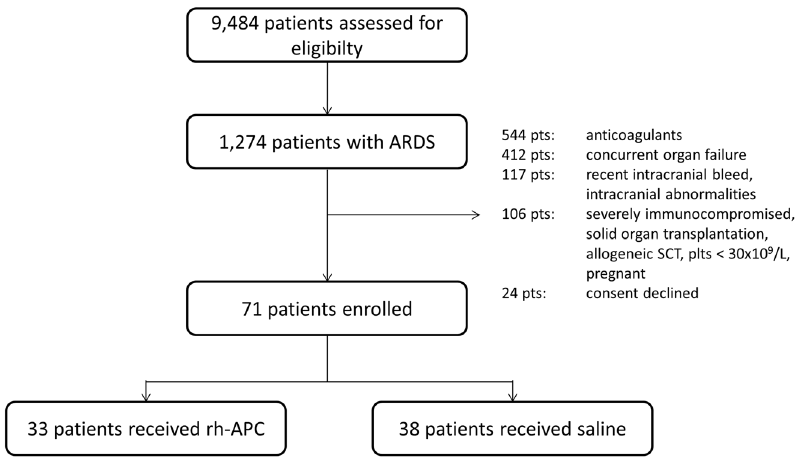
Figure 1. CONSORT diagram. ARDS, acute respiratory distress syndrome; SCT, stem cell transplantation; plts, platelet count.